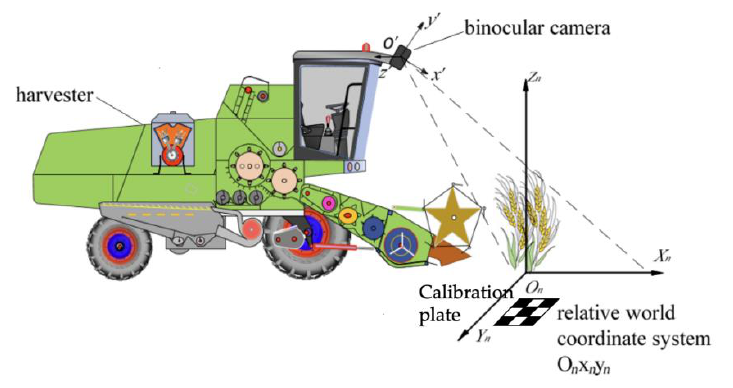
Figure 2. Wheat height detection method.